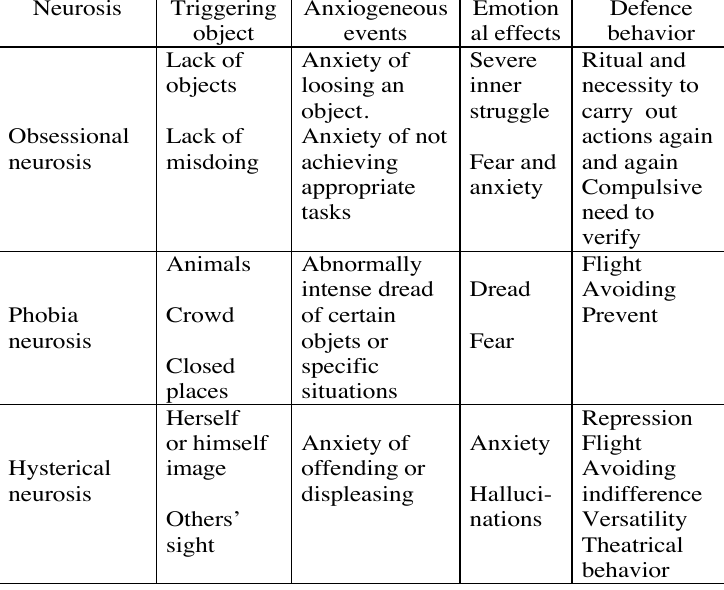
Figure 13. A simplified neurosis classification [47]. Table 3. A simplified neurosis classification